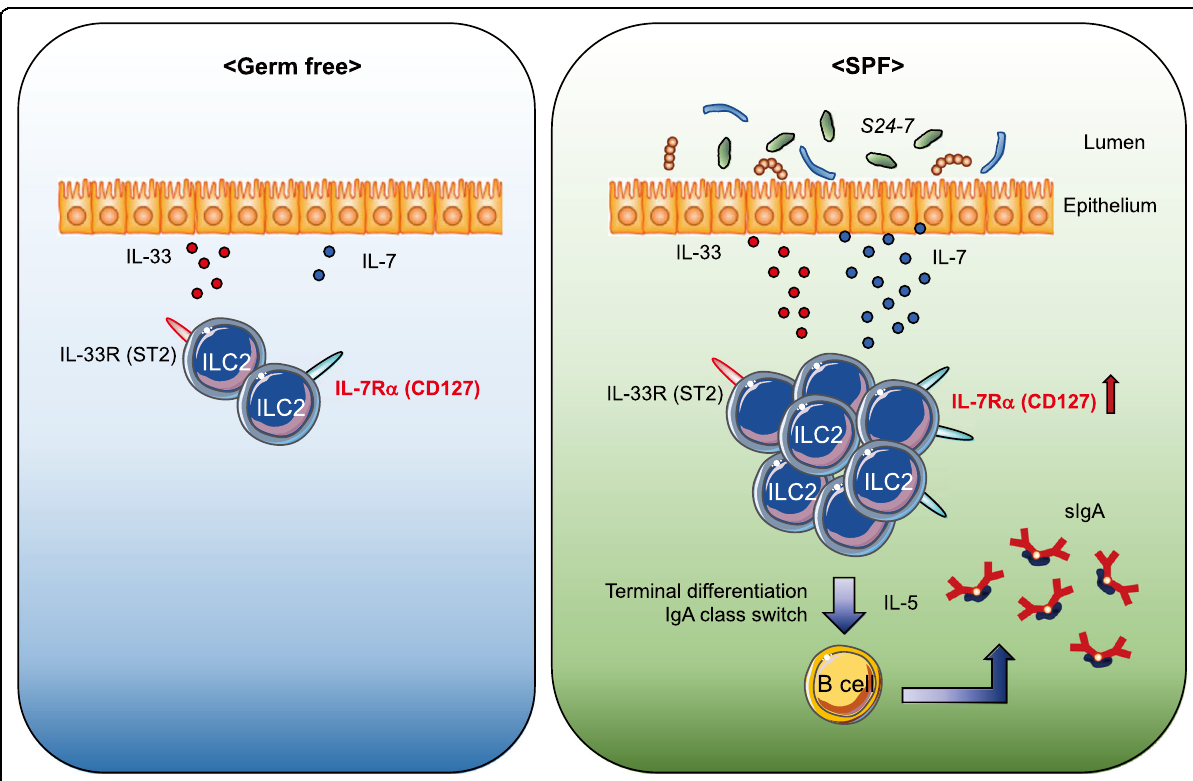
Fig. 2 Stomach ILC2s. In germ-free (GF) mice, there are few ILC2s. Under GF conditions, IL-7 expression in stomach tissue is hardly detectable, and IL-7 receptor expression on stomach ILC2s is lower than that under SPF conditions. In contrast, the expression of the IL-33 receptor on stomach ILC2s is similar and that of IL-33 in the stomach tissue is slightly decreased in GF compared to SPF conditions. Under SPF conditions, the combination of IL-33 and IL-7 signaling leads to IL-5 secretion by ILC2s, which then promotes IgA production from plasma B